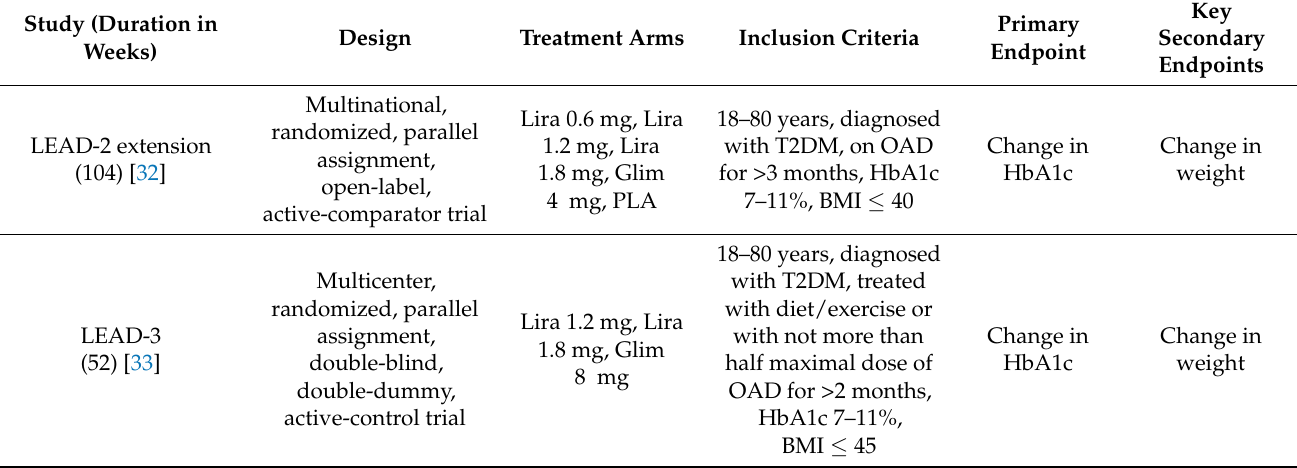
Table 1. Design of phase III RCT in type 2 diabetes included in the